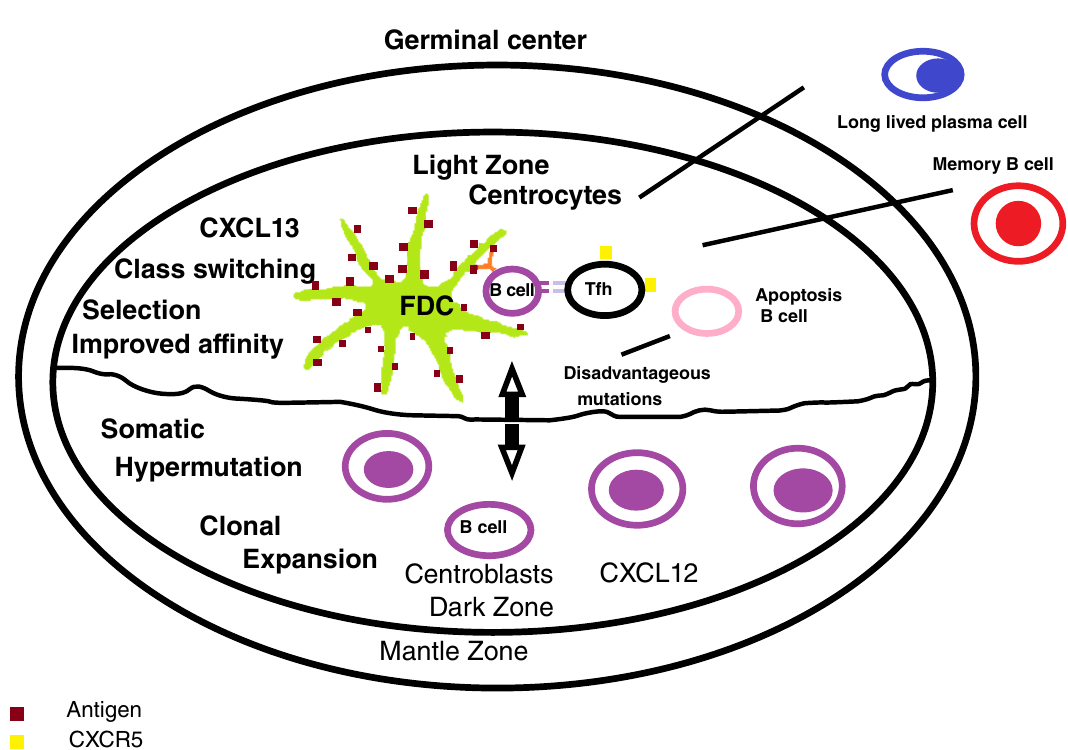
Figure 2. The germinal center. B-cells enter the dark zone of the germinal center (centroblasts), a step which depends on the expression of CXCR4 in the surface, where the cells go through proliferation and somatic hypermutation (SHM). Subsequently, the cells migrate to the light zone (centrocytes) where they capture antigens through the mutated B cell receptors and are internalized for presentation to the T cells. The centrocytes differentiate from the centroblasts by the level of expression of surface proteins. Centrocytes are CXCR4 low , CD83 high , CD86 high and the centroblasts are CXCR4 high , CD83 low y CD86 low . The fluctuation between centroblasts and centrocytes is part of a synchronized cellular program which permits a temporal separation of the processes of mitosis and SHM from selection. The functional output of the TLO, in comparison to the SLO, could result from the dysregulated nature of their GC response supporting a breakout of autoimmune variants and the development of long lasting humoral autoimmunity characterized by presence of B cells with minimal memory and LLPC 15,16 . FDC: follicular dendritic cells; LLPC: long lasting plasma cells; Tfh: T follicular helper